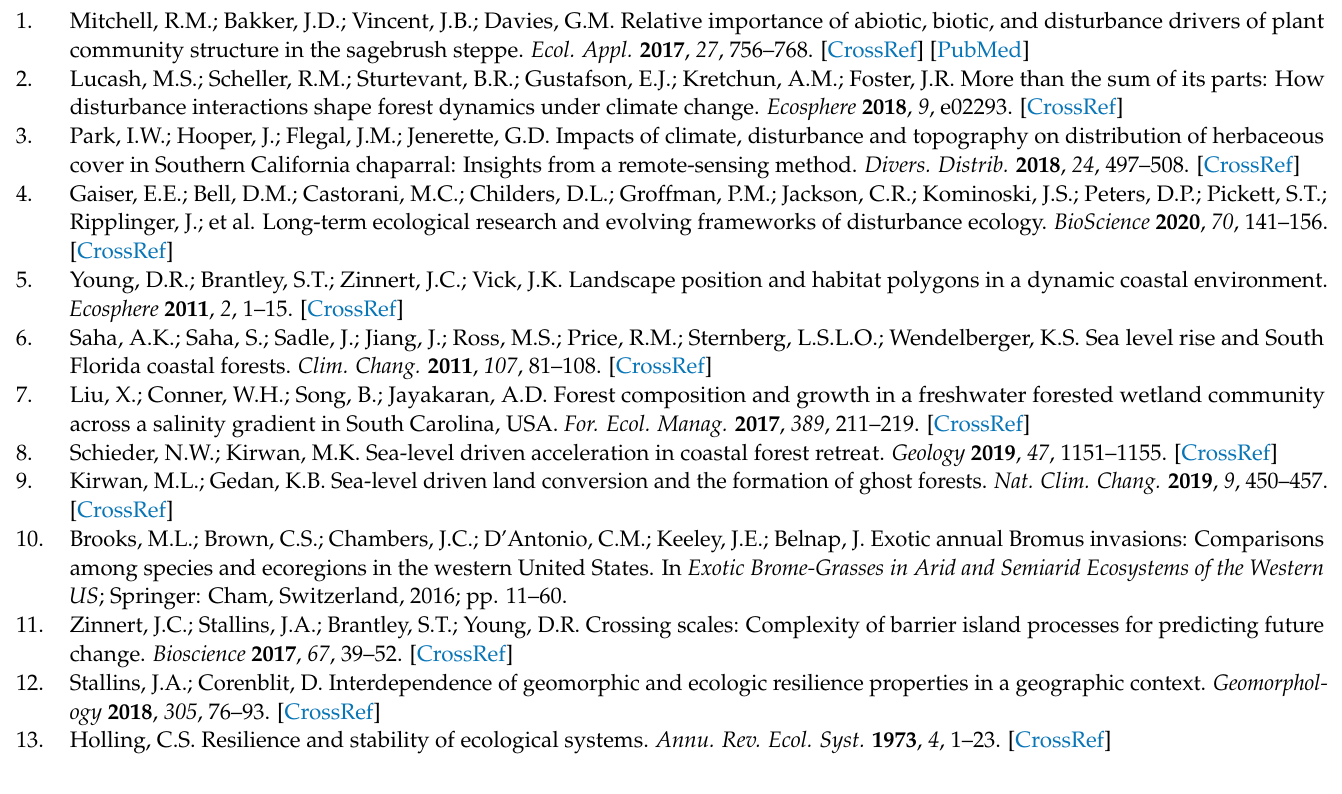
VA Lidar, Table S1: Point quarter plot summary table of the canopy layer of maritime forest Savage Neck, Table S2: Fixed radial plot summary table of the canopy layer of maritime forest on Parramore Island,